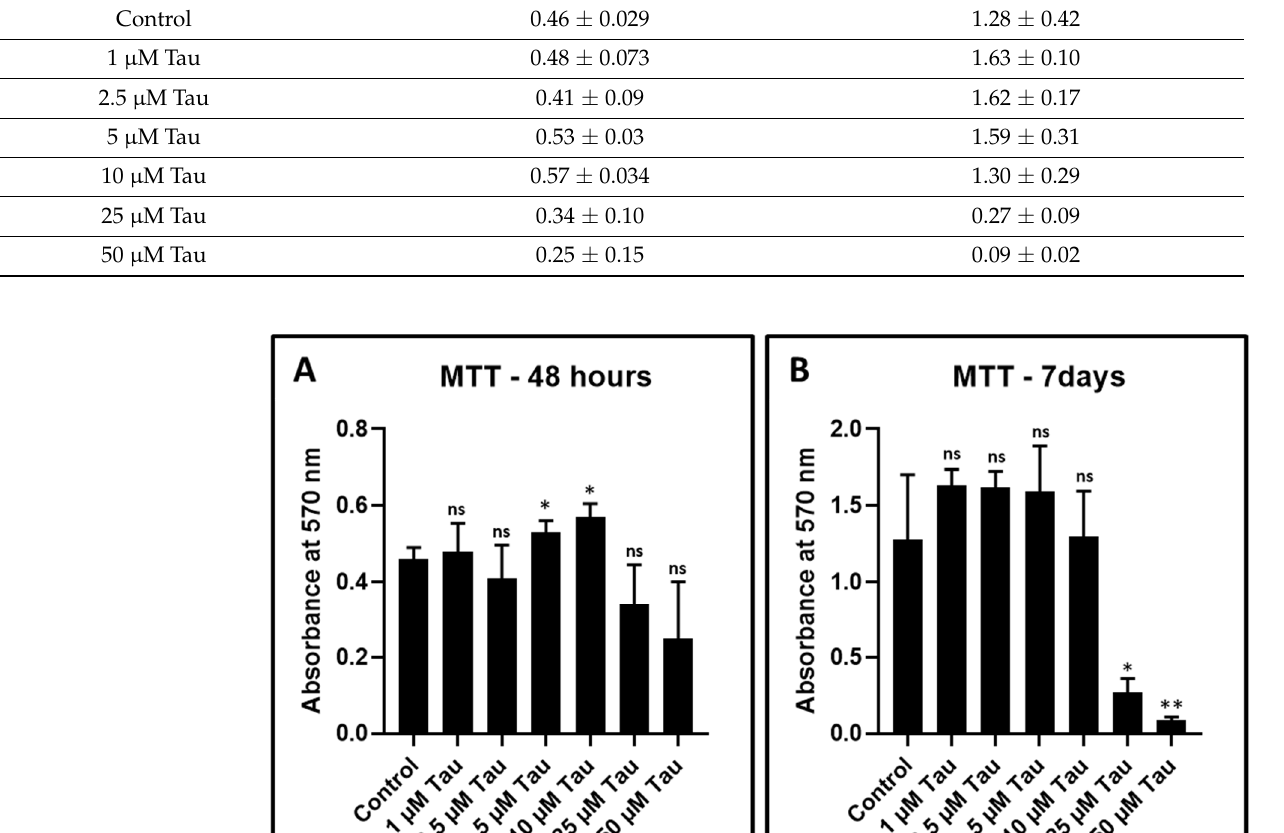
Table 4. MTT assay—absorbance at 570 nm.